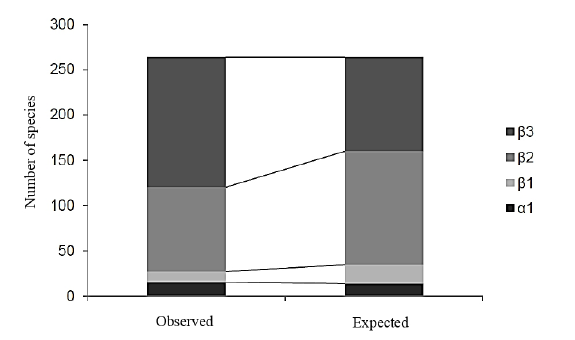
Figure 10: Analysis of additive partition of ant diversity in the Rashad District. α 1 is the average number of species in the plots. β 1 is the exchange of species between plots within the exact location. β 2 is the exchange of species between locations belonging to the same type of agroecosystem or phytophysiognomy. β 3 is the exchange of species between different types of agroecosystems and